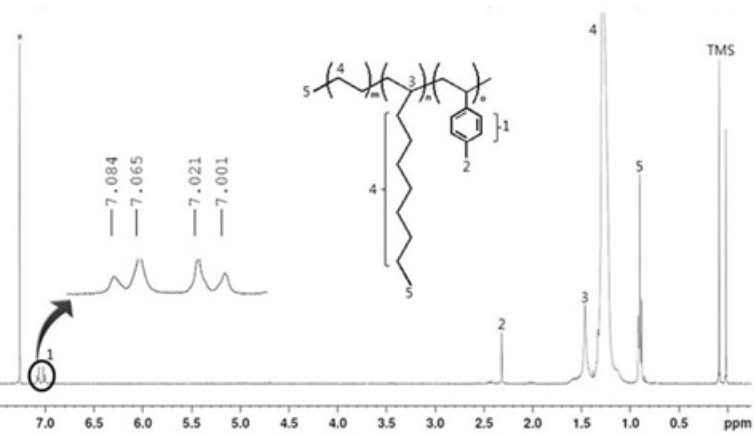
Figure 3. 1 H NMR spectrum for the terpolymer